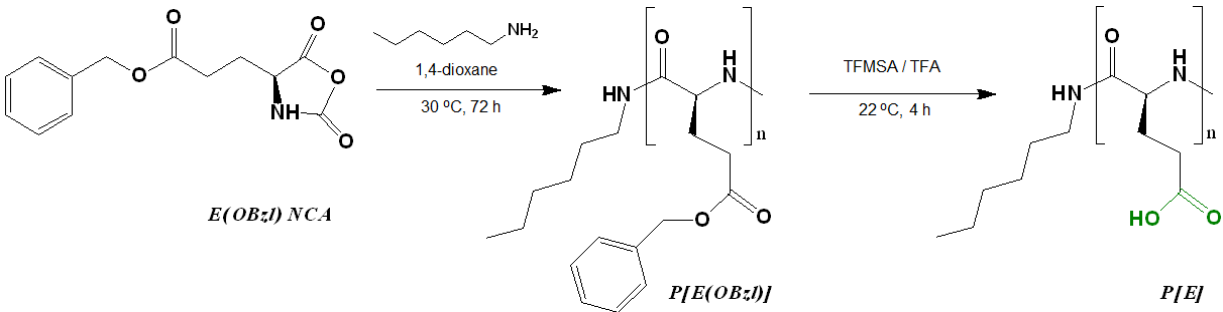
Figure 1. Scheme of the synthesis of poly( α‐ glutamic acid) by the ring ‐ opening polymerization of the N ‐ carboxyanhydride of L ‐ glutamic acid γ‐ benzyl ester.